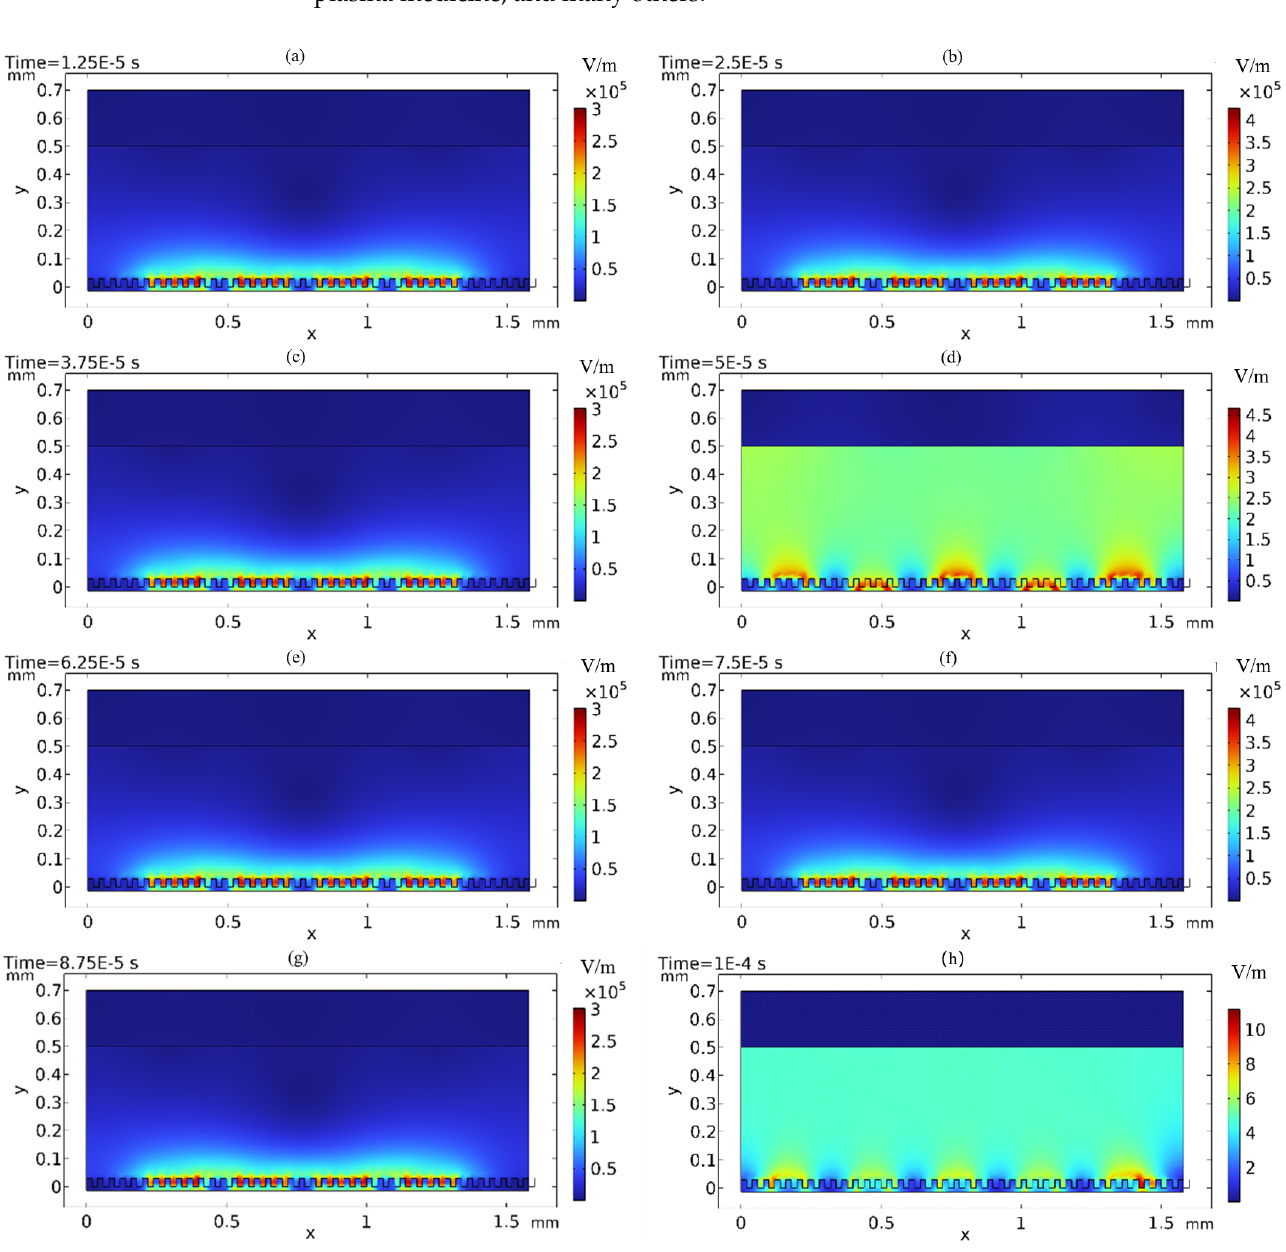
Figure 12. Evolution of the electric field intensity in the coplanar CPED device. ( a ) 1/8 T, ( b ) 1/4 T, ( c ) 3/8 T, ( d ) 1/2 T, ( e ) 5/8 T, ( f ) 3/4 T, ( g ) 7/8 T, ( h ) 1 T.